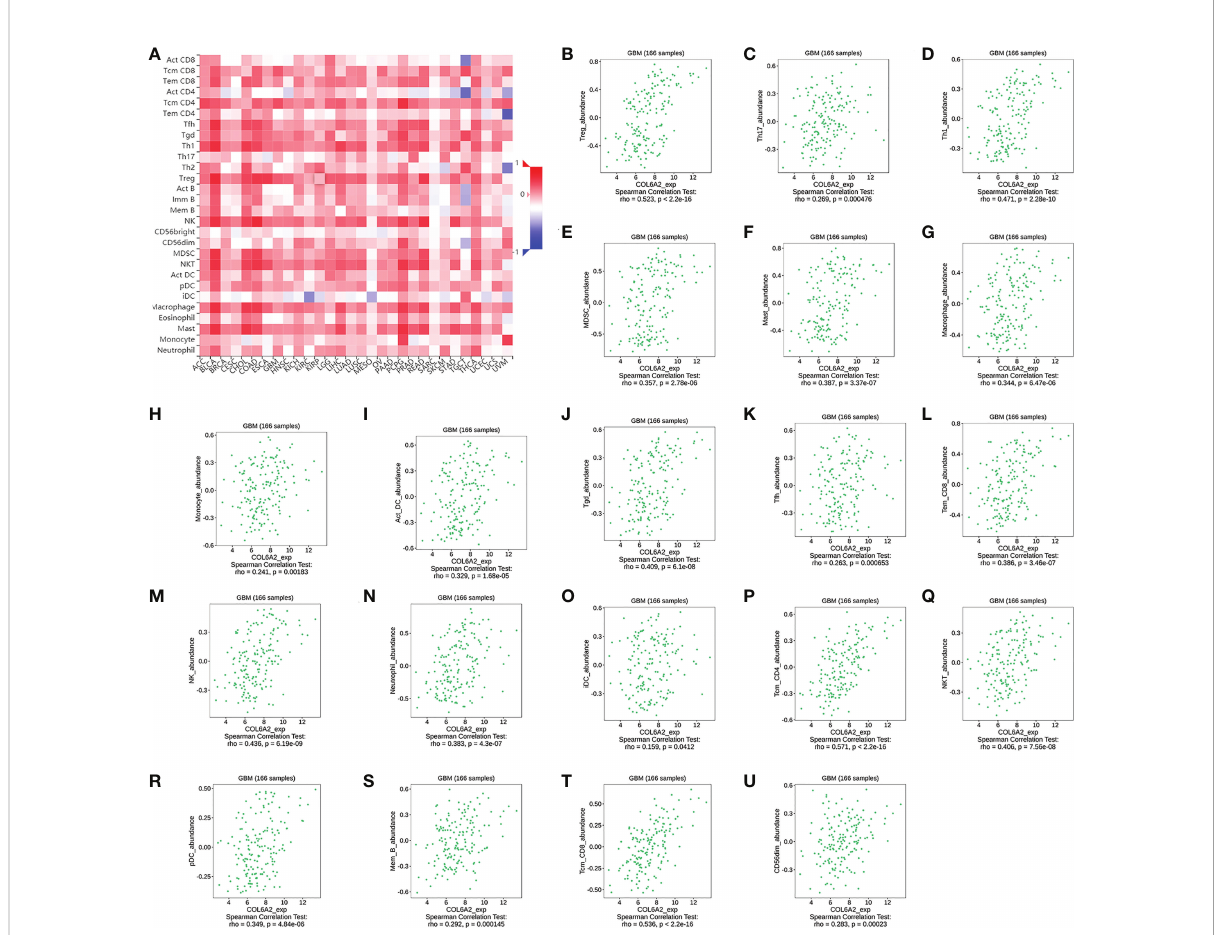
FIGURE 10 Correlation of COL6A2 expression with various B and T immune cell in fi ltration levels in GBM by TISIDB database. (A) Heatmap of the correlation between COL6A2 expression and lymphocytes, red, positive correlation, blue, negative correlation. (B – U) COL6A2 expression is signi fi cantly positively correlated with regulatory T cell, Type 17 T helper cell, Type 1 T helper cell lymphocytes in GBM. GBM,